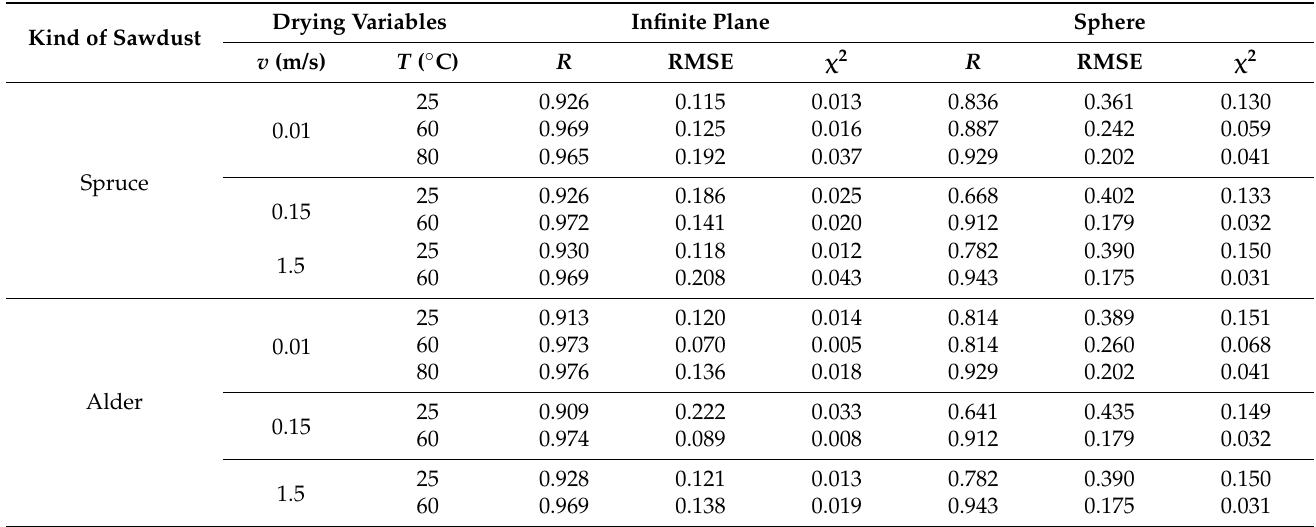
Table 5. Comparison of results of statistical analyses on the modeling of spruce and alder drying using theoretical models and moisture diffusion coefficient determined by Equation (7). Kind of